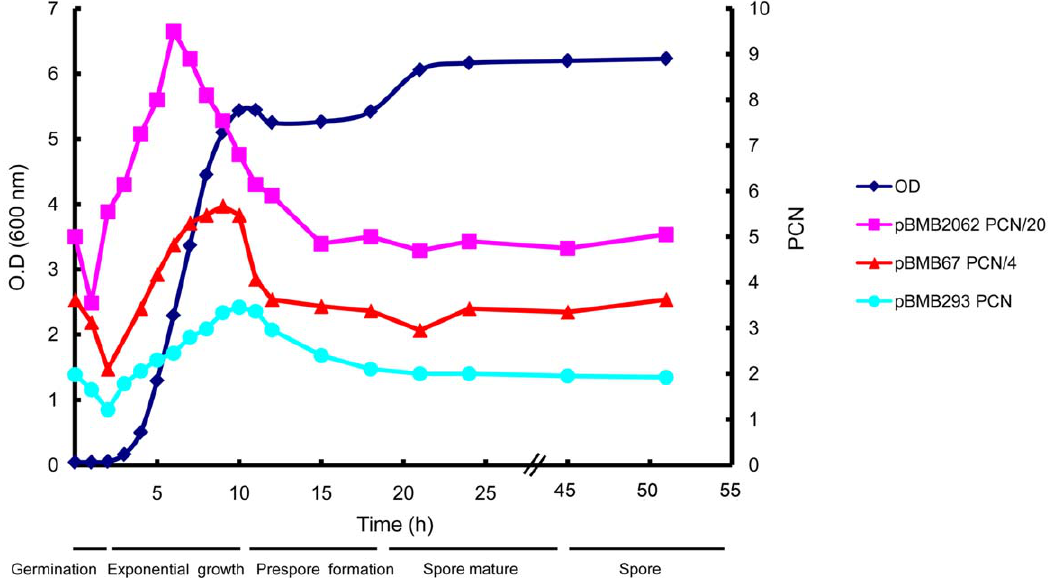
Figure 2. The PCNs of pBMB2062, pBMB67, and pBMB293 vary over the life cycle of B.thuringiensis YBT-1520. Spores were inoculated in LB medium to develop into the germination, growth, and spore stages. To show the PCNs of the three plasmids varied widely, we plotted the data for all three plasmid on the same figure: the pink squares represent the PCN of pBMB2062 divided by 20; the red triangles represent the PCN of pBMB67 divided by 4, the aqua circles represent the PCN of pBMB293; and the blue rhombus represent the bacteria’s absorbance (OD 600 ).